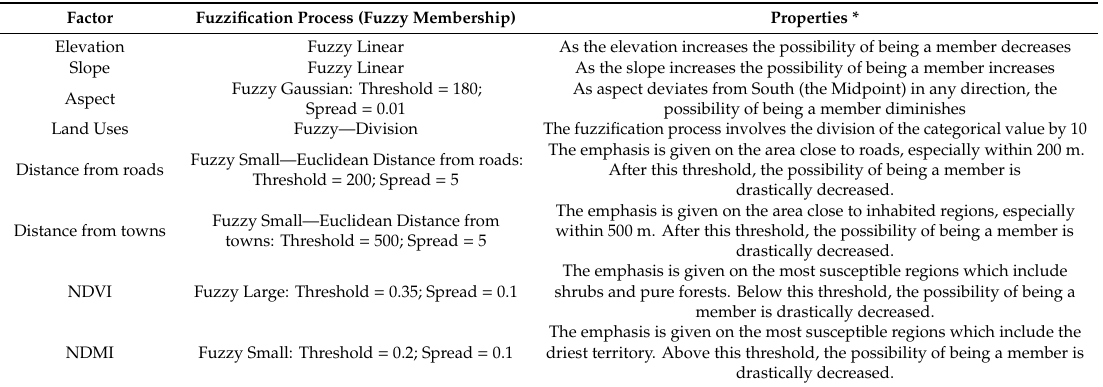
Table A2. Fuzzy modeling of fire hazard